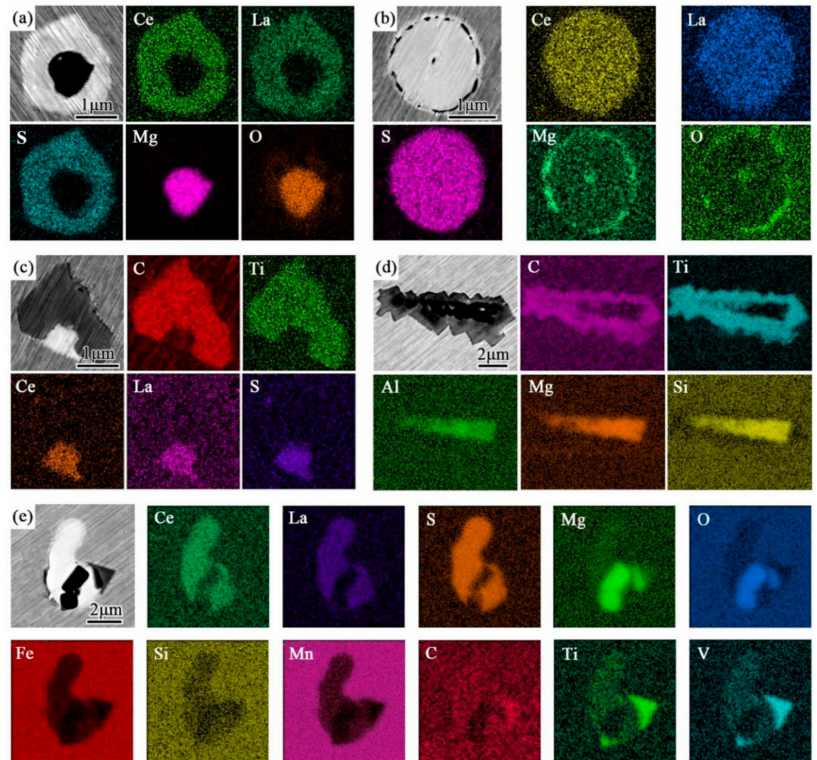
Figure 4. The morphology and element distribution of composite inclusions: ( a ) MgO surrounded by RE 2 S 3 , ( b ) RE 2 S 3 surrounded by MgO, ( c ) carbide accompanied by RE 2 S 3 , ( d ) carbide with the core of Al-Mg-Si inclusion, ( e ) aggregated multiple inclusions (RE 2 S 3